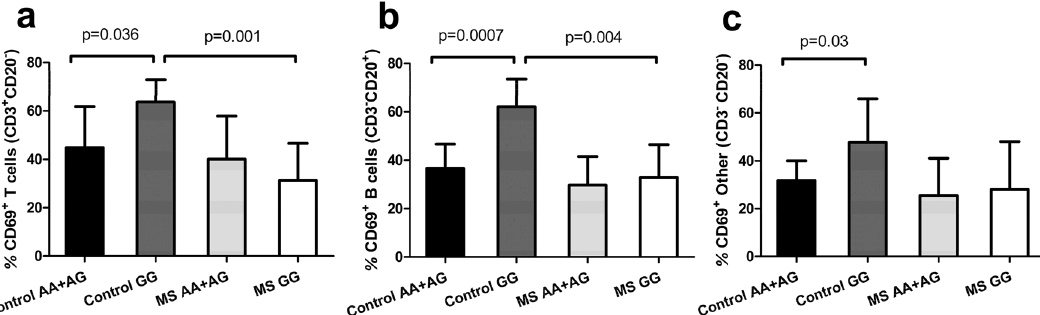
Figure 3. Lymphocyte activation in healthy controls and MS patients stratified by rs4912622 genotype. Effect of rs4912622 genotypes on surface expression of CD69 in ( A ) CD3 + CD20 - lymphocytes (control AA + AG: n = 11; control GG: n = 5; MS AA + AG: n = 16; MS GG: n = 8); ( B ) CD3 - CD20 + (control AA + AG: n = 10; control GG: n = 5; MS AA + AG: n = 15; MS GG: n = 6). ( C ) CD3 - CD20 - (control AA + AG: n = 10; control GG: n = 5; MS AA + AG: n = 16; MS GG: n = 8). Means of the percentage of cells expressing CD69 ± standard deviation are